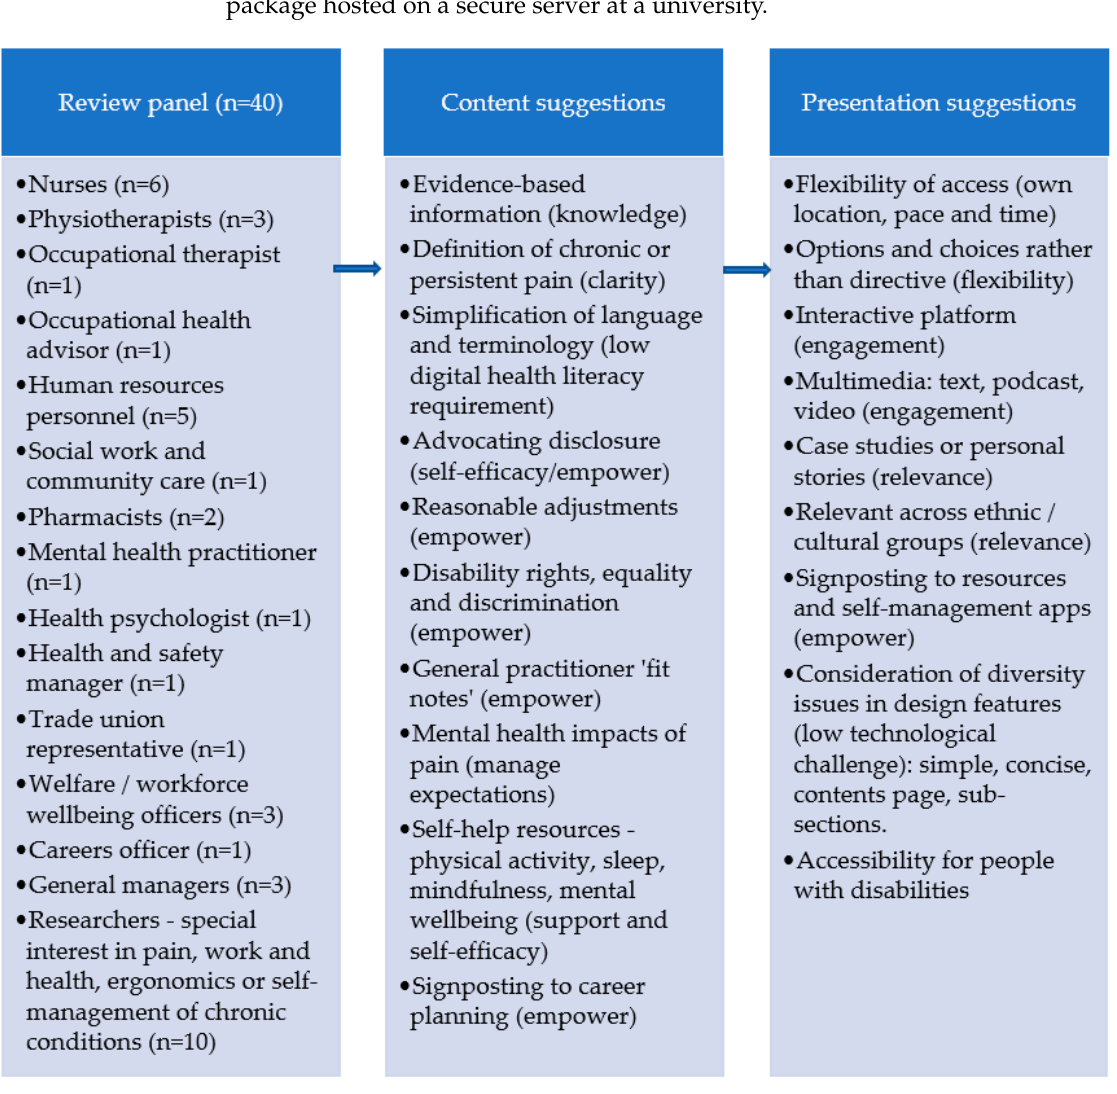
Figure 2. Examples from the peer review process .